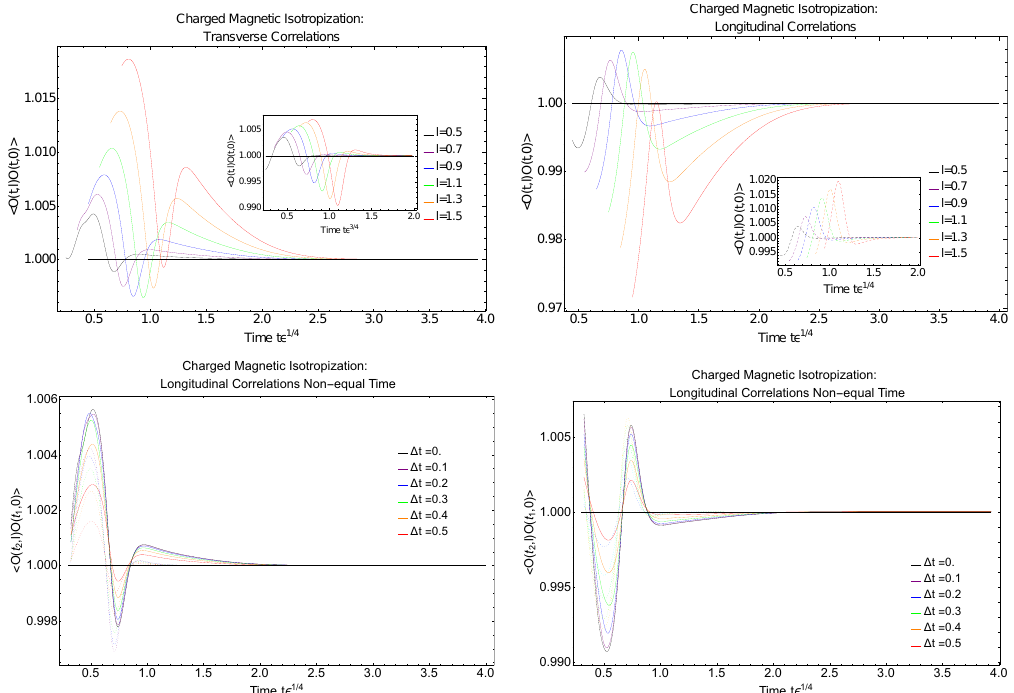
Figure 17 . 2-point correlation functions of an (uncharged) scalar operator in a neutral thermalizing (cid:13)uid (dual to evolution towards a charged magnetic black brane geometry), (cid:26) = 0 : 78 (cid:26) e , B = 1, case (c) in (cid:12)gure 1. Top Left: various length separations in the transverse direction at (cid:1) t = 0. Top right: various length separations in the longitudinal direction at (cid:1) t = 0. Bottom left: various time separations (cid:1) t , (cid:12)xed transverse length separation l = 0 : 65. Bottom Right: various time separations (cid:1) t , (cid:12)xed longitudinal length separation (cid:1) l = 0 : 65. The purely anisotropic case (a) is shown for comparison in the top graphs as an inset, and in the bottom graphs as dashed